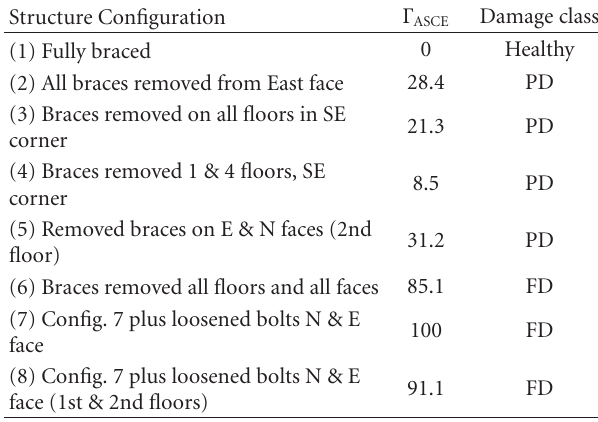
Table 2: Damage cases and quantified damage metric ( Γ ASCE ) based on experimental description of damage in ASCE benchmark structure.